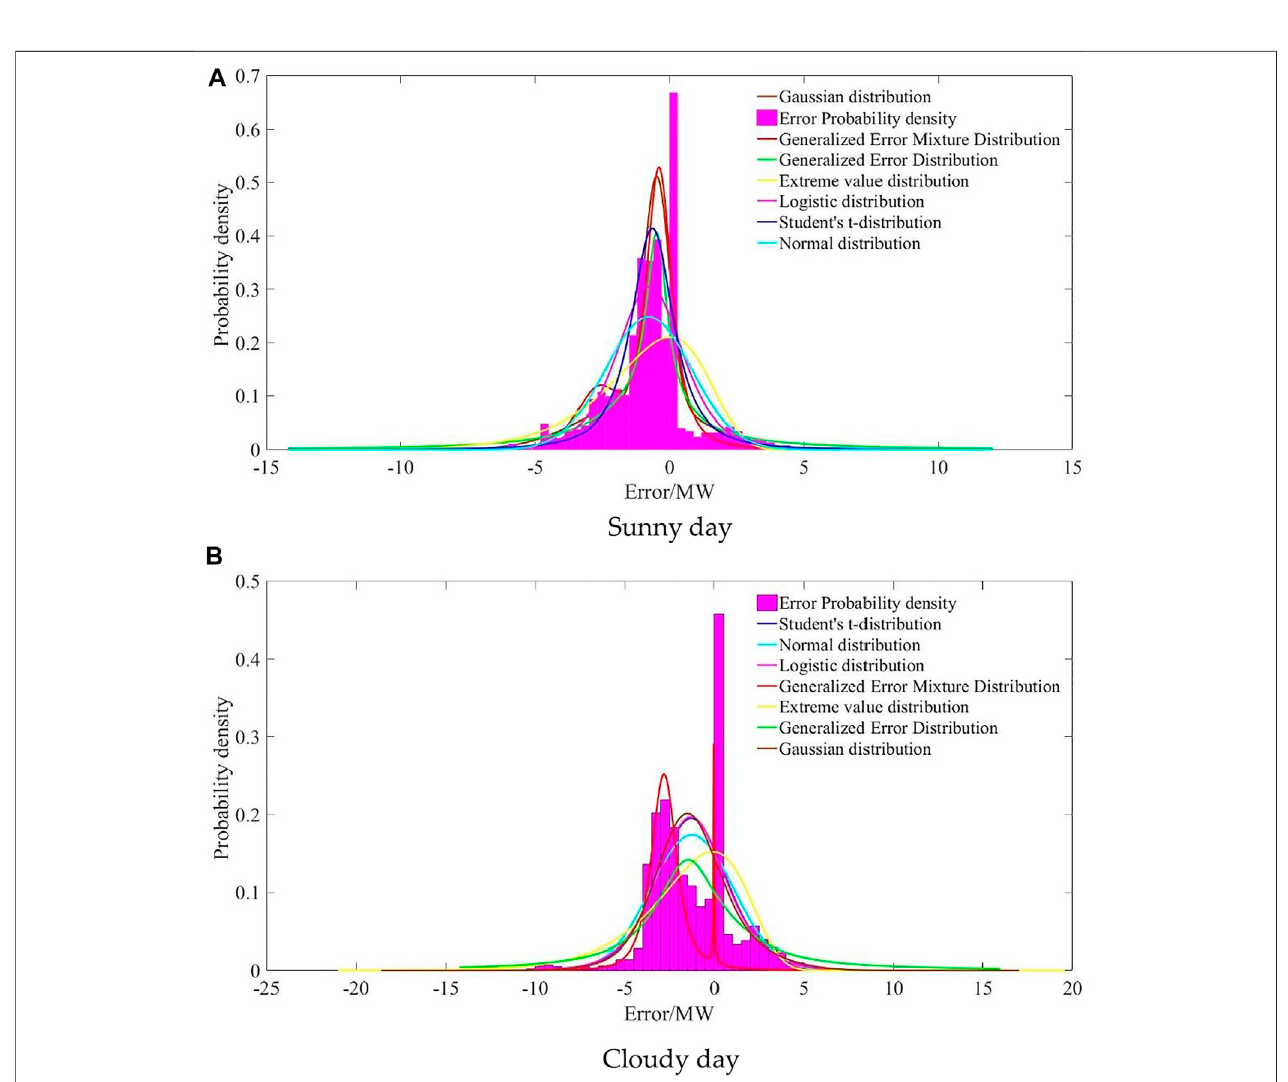
FIGURE 7 | Comparison of fi tting effects of fi ve error distribution models. (A) Sunny day (B) Cloudy day